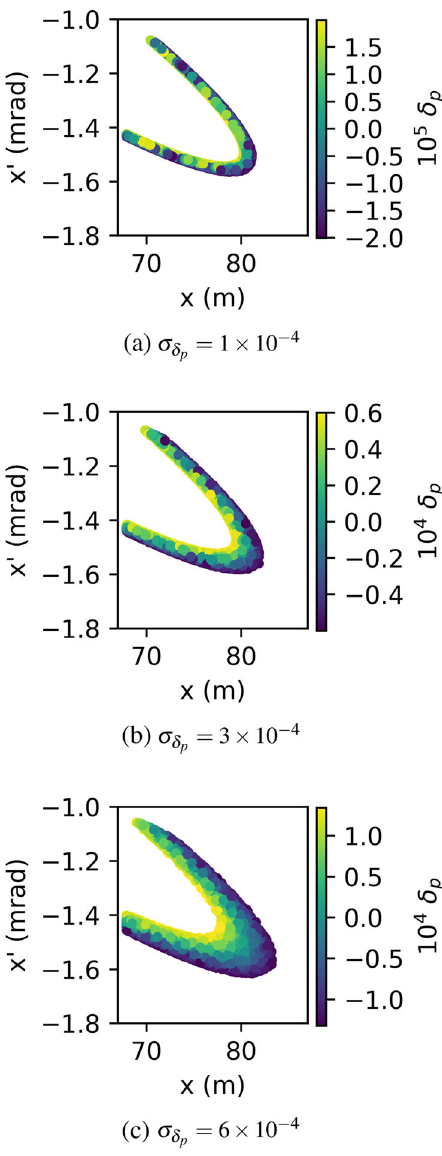
FIG. 5. Impact of the instantaneous momentum spread ( σ δ (proportional to the resonance stop-band width) on the instanta- neous phase space presentation of the beam to the high-field side of the